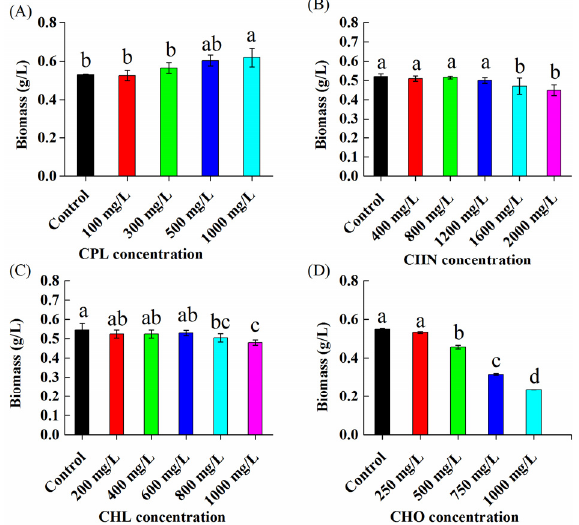
Figure 4. Effects of organic matters on the growth of Arthrospira platensis . ( A ) Caprolactam (CPL), ( B ) cyclohexanone (CHN), ( C ) cyclohexanol (CHL), ( D ) cyclohexanoneoxime (CHO). Error bars represent the standard deviation ( n = 3). Data with different letters indicate significant differences ( p < 0.05) between the control and treatment.